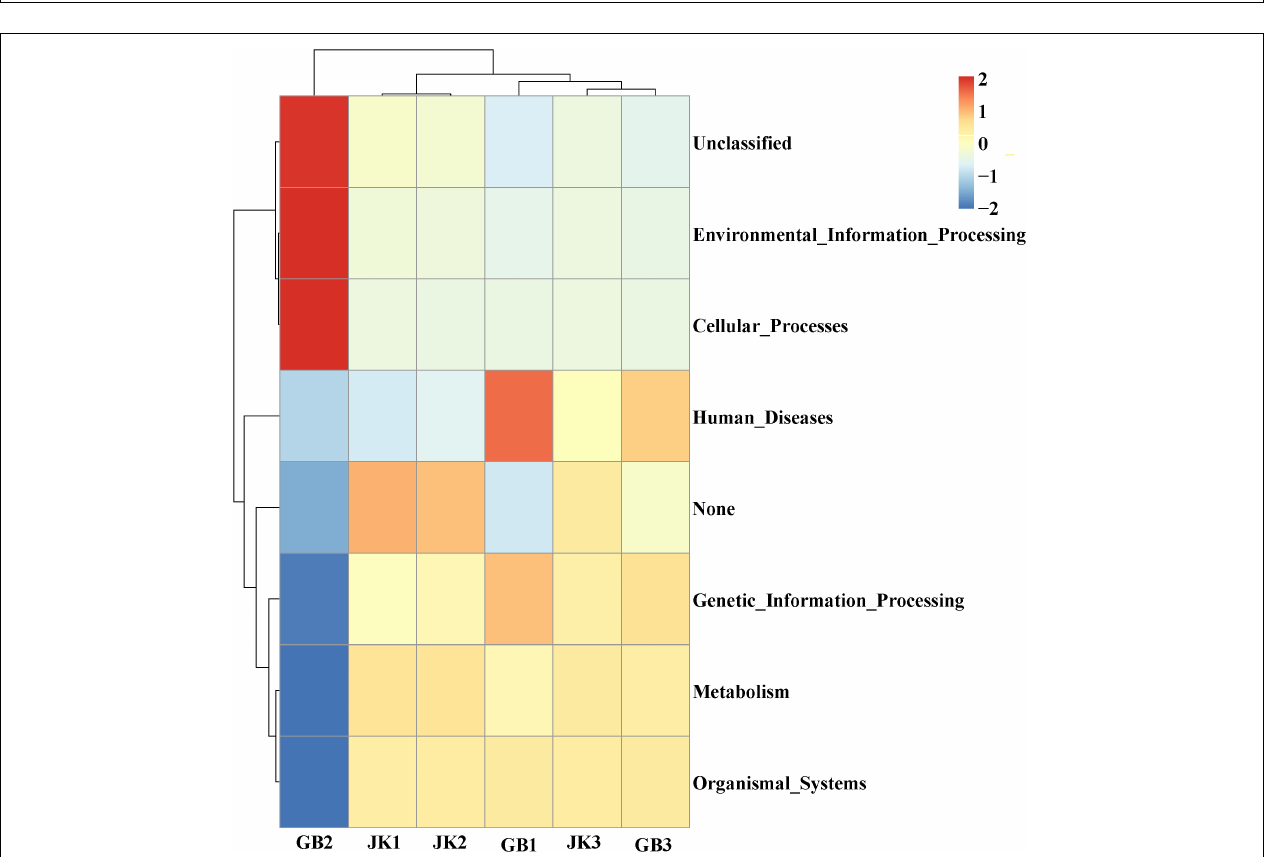
FIGURE 5 | Dendrogram of bacterial functional categories in symptomatic (GB1, GB2, GB3) and asymptomatic samples (JK1, JK2, JK3) analyzed using PICRUSt.